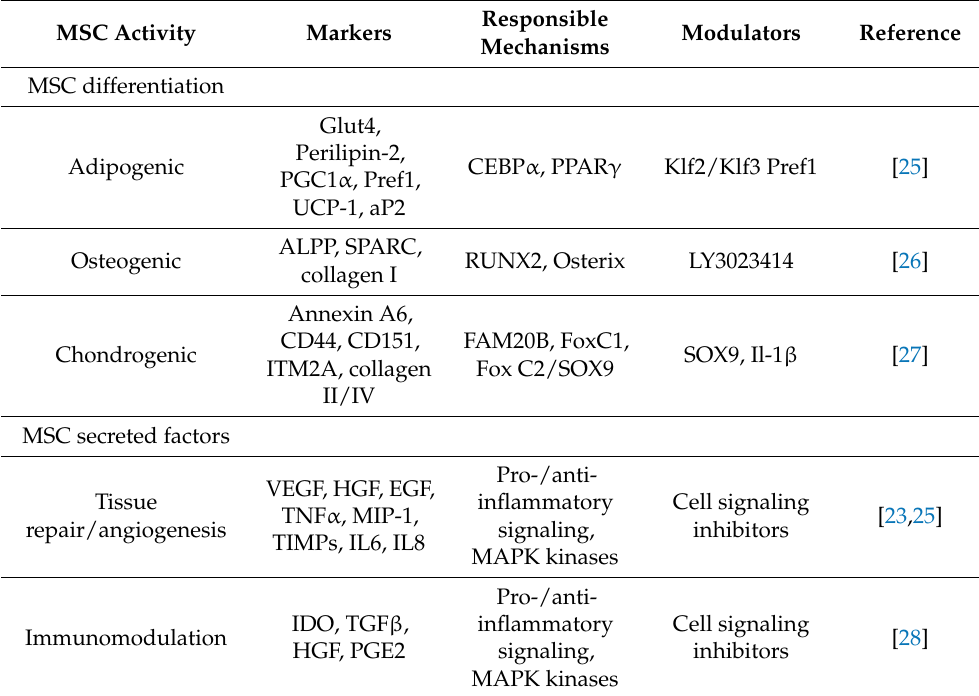
Table 1. Factors having impact on MSC differentiation and production of MSC-derived repairing and immunomodulatory